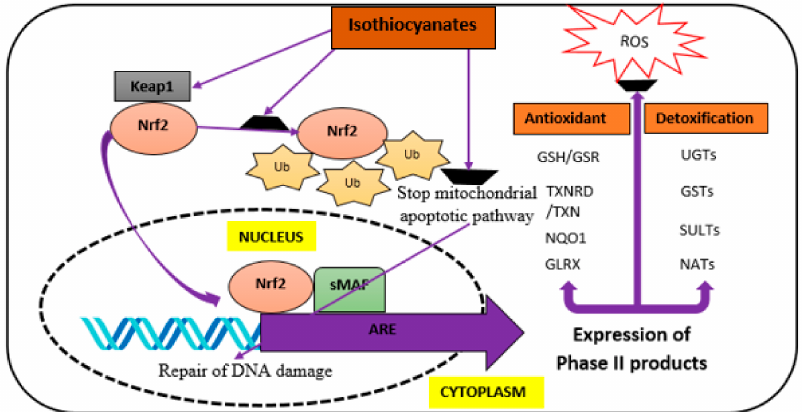
Figure 4. Proposed molecular mechanism of actions through which ITCs elicit their neuroprotective effect. ARE, Antioxidant response element; Glrx, Glutaredoxin; GSH, Glutathione; GSR, Glutathione-disulfide reductase; GSTs, Glutathione S -transferase; Keap1, Kelch-like